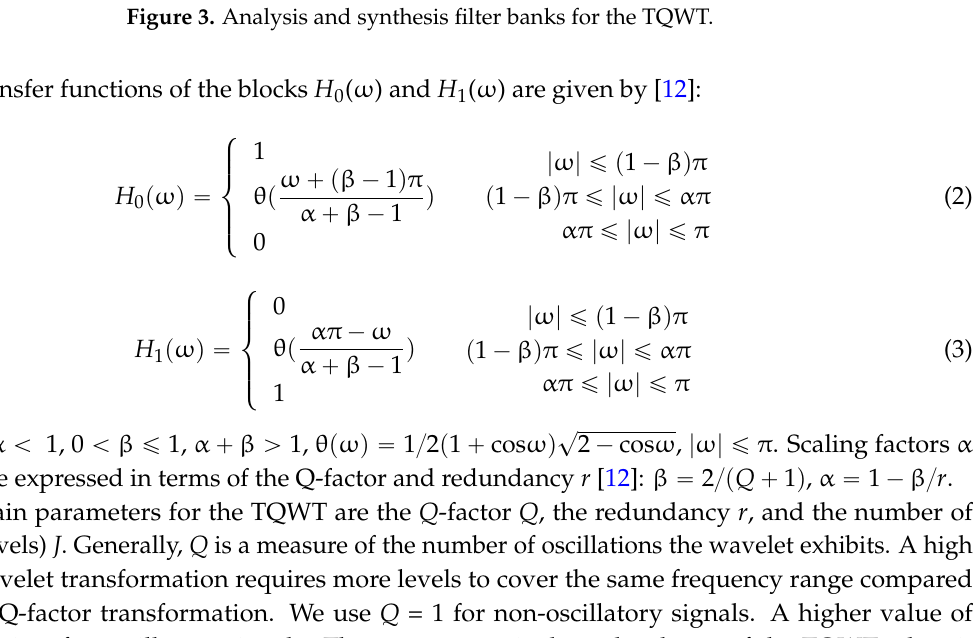
Figure 3. Analysis and synthesis filter banks for the